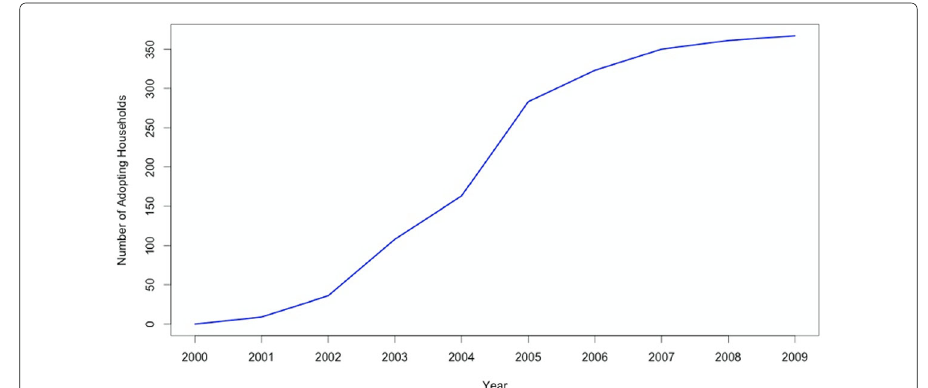
Fig. 2 Diffusion of the new crop in the Chinese